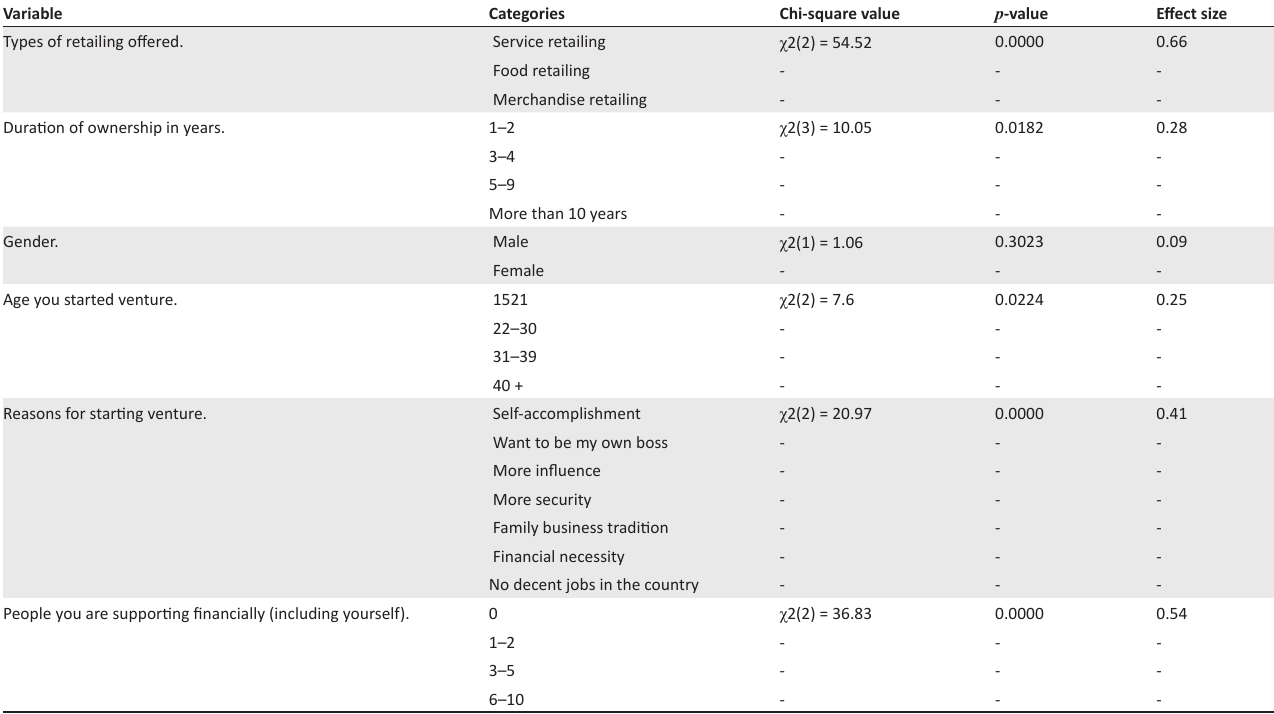
TABLE 7: Differences between clusters on sample characteristics.